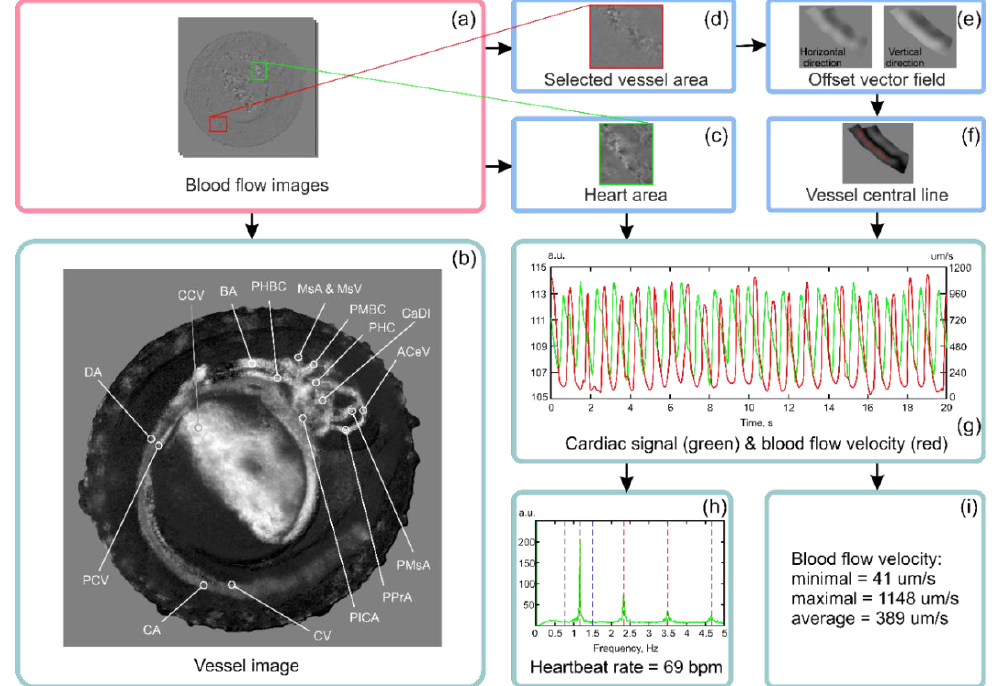
Figure 4. Example of cardiovascular data extraction using the proposed algorithm: ( a ) blood flow images, ( b ) vessel image, ( c ) the selected heart area, ( d ) the selected vessel area, ( e ) o ff set vector field examples, ( f ) the detected vessel central line, ( g ) cardiac signal and blood flow velocity examples, ( h ) cardiac signal spectrum, ( i ) blood flow velocity range and average